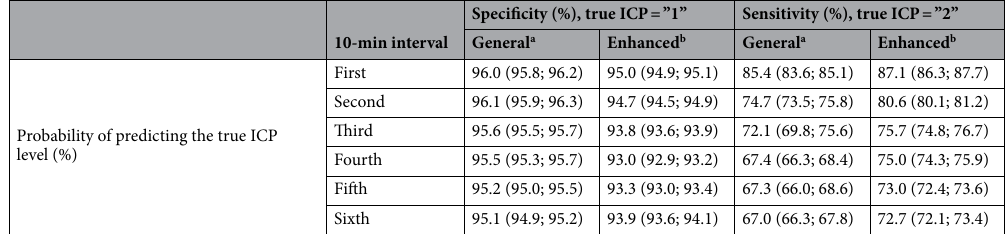
Table 2. Prediction accuracy (non-parametric bootstrap 95% CI). a General predictions based on maximum likelihood estimation. b Enhanced predictions obtained with α = 0.60.